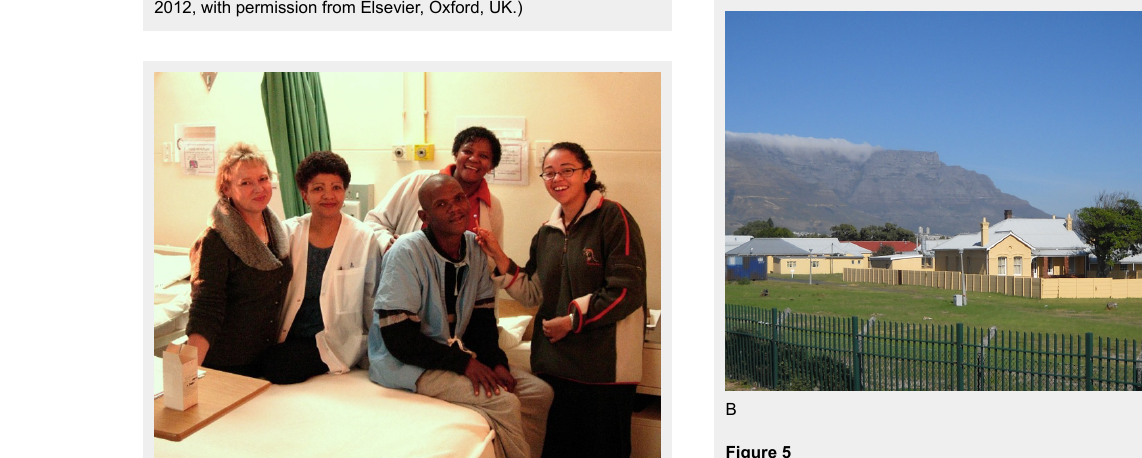
2012, with permission from Elsevier, Oxford,